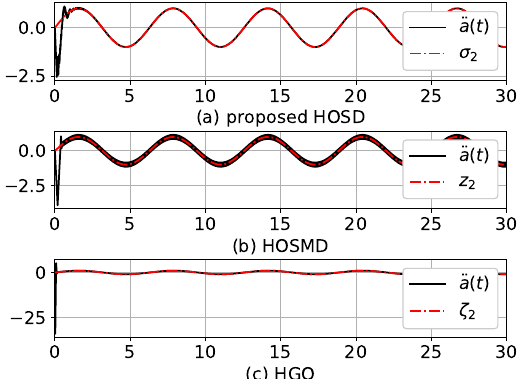
Figure 5. Estimations of ¨ a using parameter set 2 (cid:13) in Table 1.